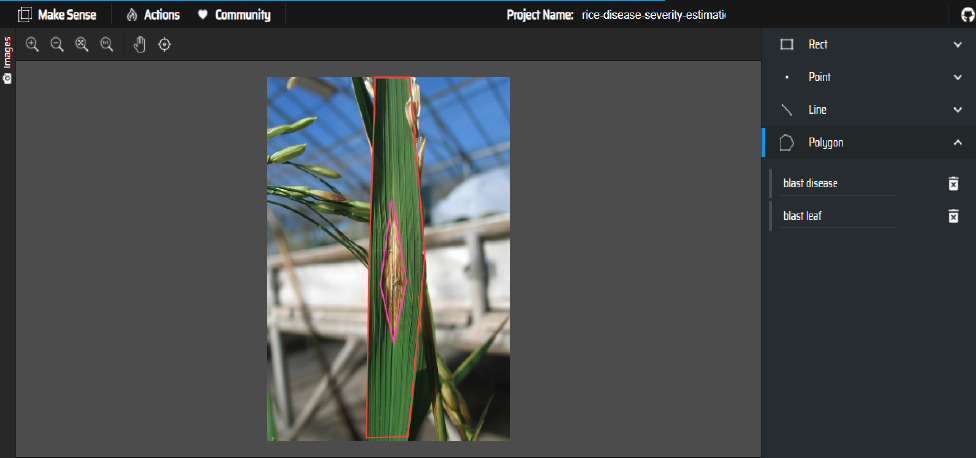
Figure 3. Rice leaf and diseased area image annotation performed using Make Sense tool.